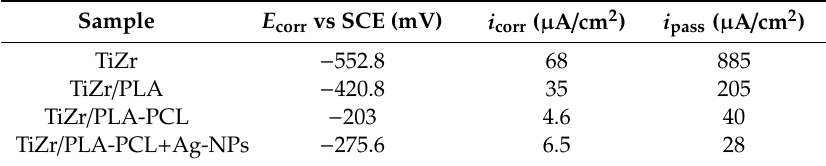
Figure 3. Polarization curves for ( a ) TiZr; ( b ) TiZr / PLA;.( c ) TiZr / PLA-PCL; ( d ) TiZr / PLA-PCL + Ag-NPs in SBF solution. Table 6. Electrochemical parameters for the analysed